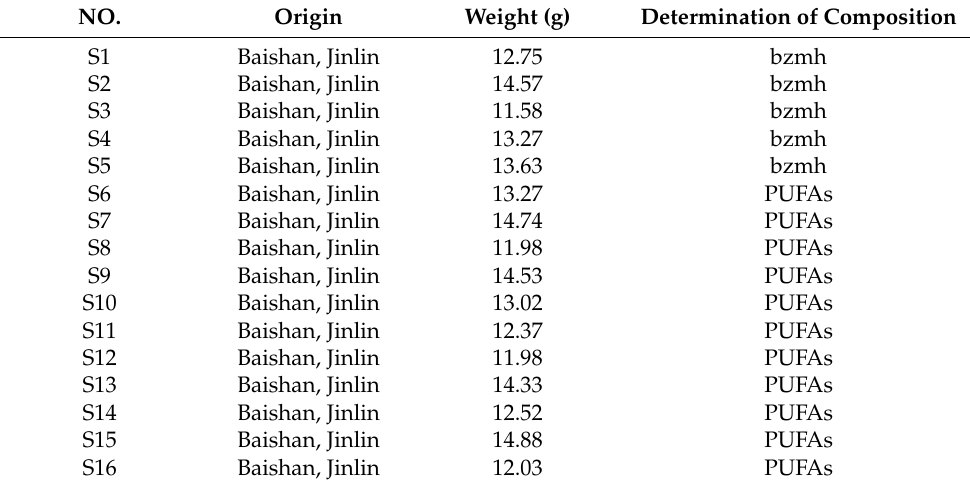
Table 1. Information of Rana chensinensis samples.